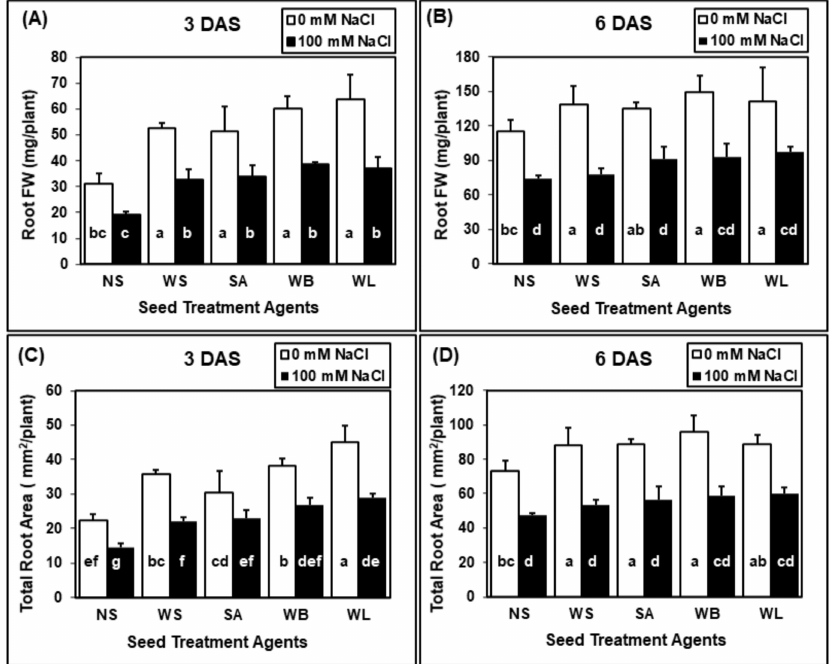
Figure 3. Effect of seed treatments (NS, non-soaked; WS, water-soaked; SA, salicylic acid (0.5 mM); WB, willow bark extract (2% w / v ); WL, willow leaf extract (2% w / v )) on root fresh weight (FW) ( A , B ) and area ( C , D ) of maize ( Zea mays cv. Caramelo) seedlings (( A , C ), 3 days after sowing (DAS); ( C , D ), 6 DAS) grown in perlite in the absence (0 mM NaCl) or presence (100 mM NaCl) of salin- ity